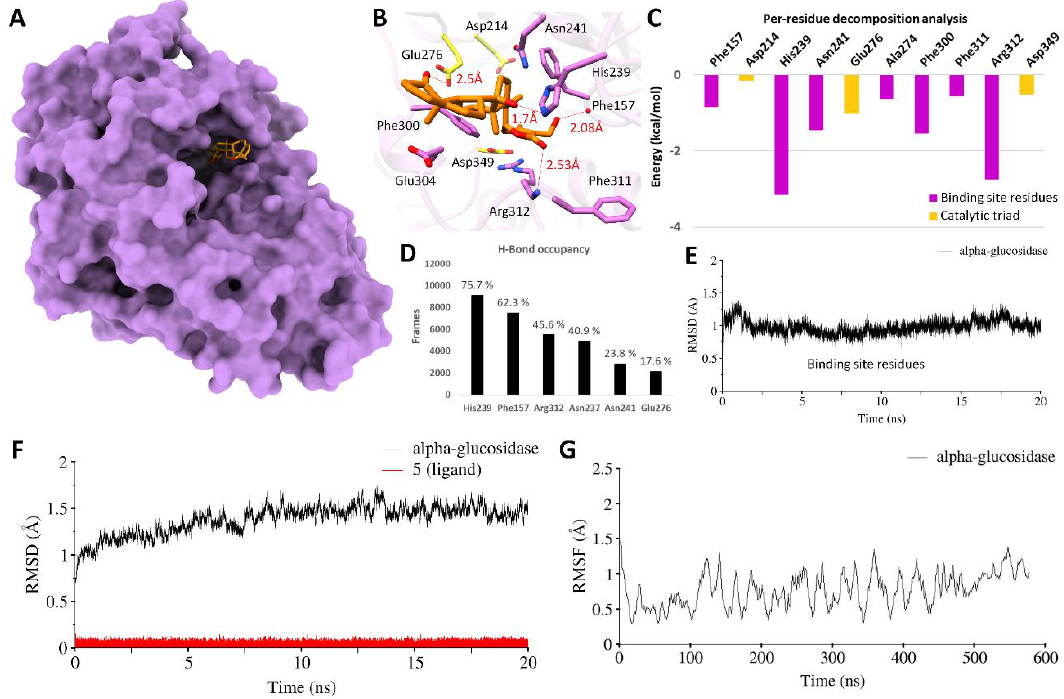
Figure 4. Molecular surface representation of α -glucosidase. ( A ) MD simulated binding pose of 5 (orange sticks) inside the binding pocket. Residues are highlighted in stick representation and catalytic triad residues are colored yellow. ( B ) H-Bonds with distance are displayed beside each bond. ( C ) Per-residue decomposition analysis of binding pocket residues, while catalytic triad residues are colored yellow. ( D ) H-Bond occupancy and ( E ) root-mean-square-deviation (RMSD) of binding pocket residues over a period of 20 ns. ( F ) RMSD of backbone atoms of α -glucosidase (in black) along with ligand (in red) and root mean square fluctuations and (RMSF) ( G ) are displayed over a period of 20 ns.